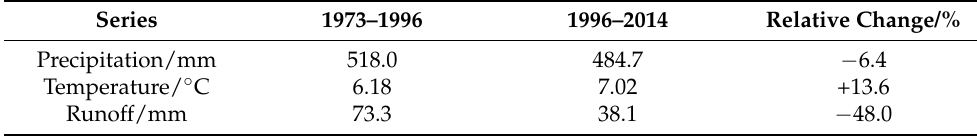
Table 3. Relative changes in precipitation, temperature, and runoff before and after